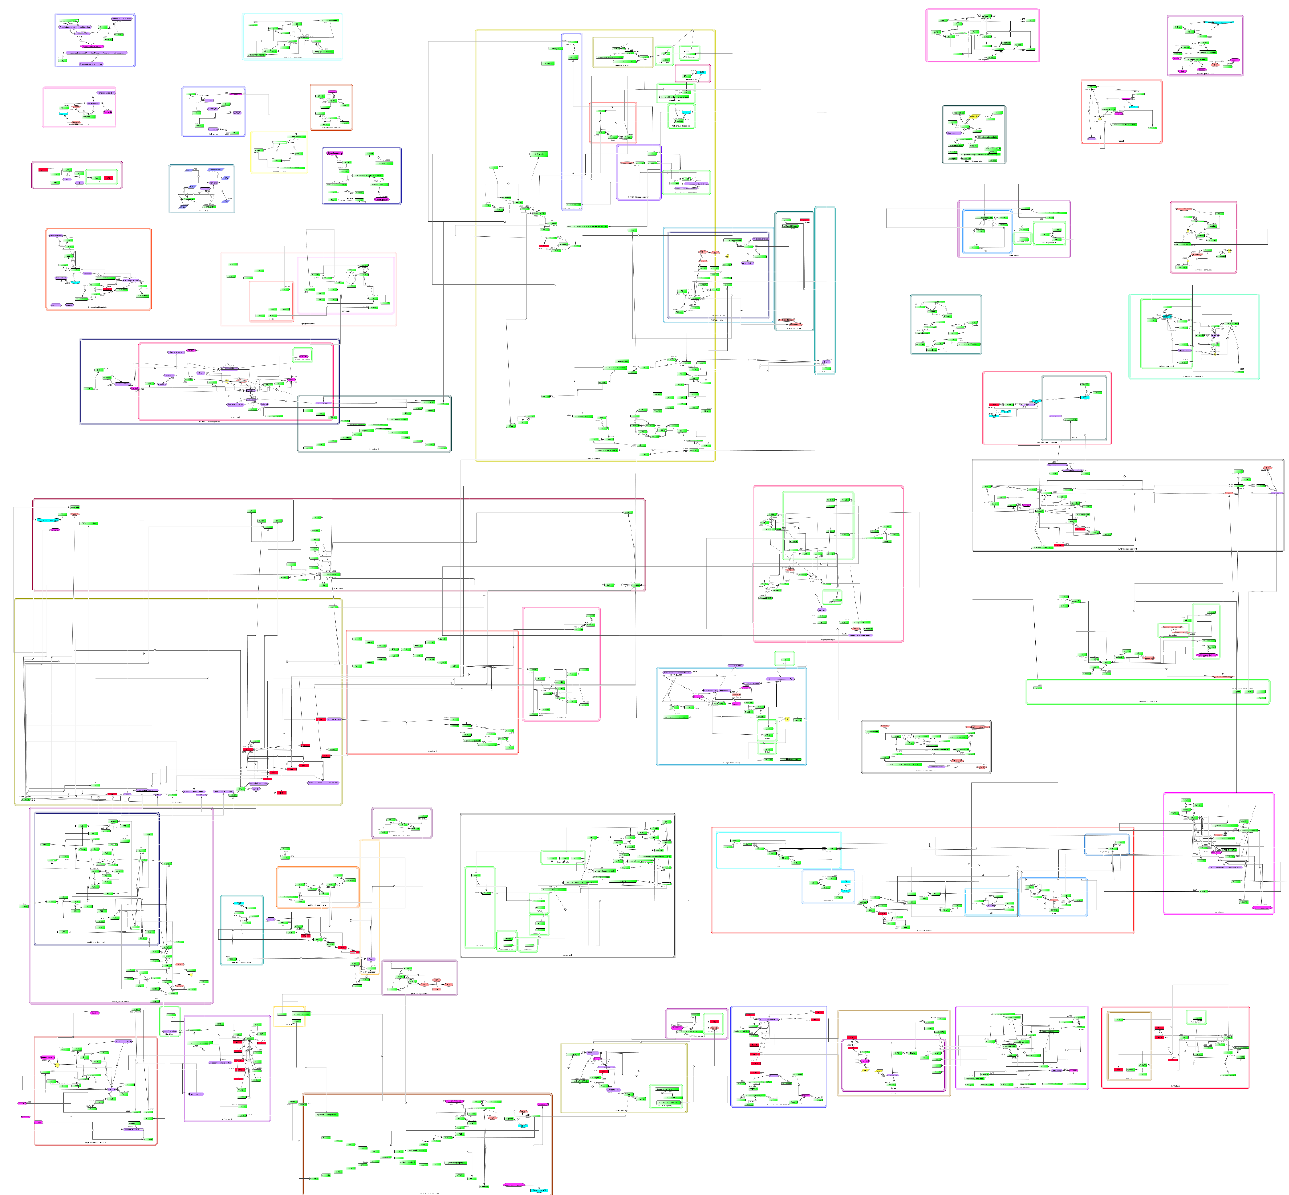
Figure 2. The network of molecules (gene, protein, drugs) involved in the 46 pathways. The network is generated in the CellDesigner software v.4.4.2. Since the figure is very large in size, we are providing alternative links in the form of PNG on our website for the user to download and view